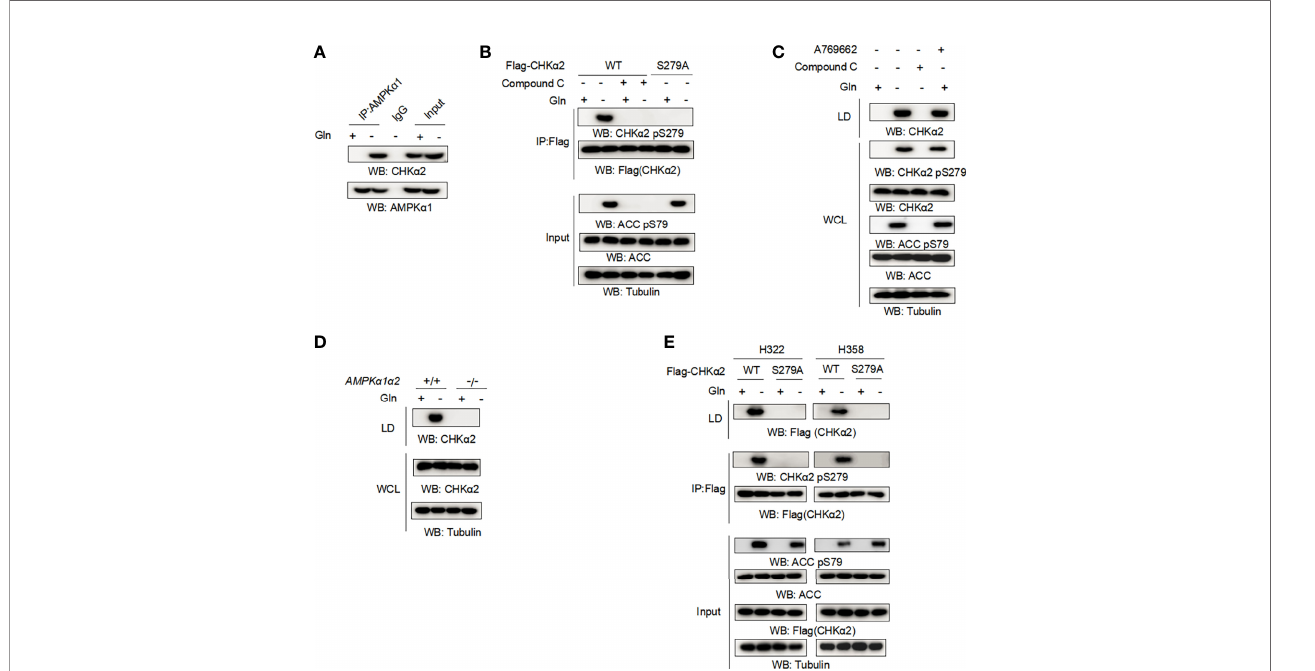
FIGURE 2 | Glutamine deprivation-induced and AMPK-mediated CHK a 2 S279 phosphorylation promotes the binding of CHK a 2 to lipid droplets. (A) H322 cells were stimulated with glutamine deprivation for 6 h. Immunoprecipitation with AMPK a 1 antibody and immunoblotting analyses with the indicated antibodies were performed. (B) H322 cells expressing WT-Flag-CHK a 2 or Flag-CHK a 2 S279A were treated with or without 5 m M Compound C for 6 h, followed by stimulation with glutamine deprivation for 6 h. Flag-CHK a 2 protein was immunoprecipitated, and immunoblotting analyses with the indicated antibodies were performed. (C) H322 cells were treated with 5 m M Compound C or 0.5 mM A769662 for 6 h and stimulated with glutamine deprivation for 6 h. The lipid droplets were puri fi ed and normalized to cell numbers. Immunoblotting analyses were performed with the indicated antibodies. (D) AMPK a 1 a 2-de fi cient MEFs were stimulated by glutamine deprivation for 6 h before lipid droplet puri fi cation. Immunoblotting analyses were performed with the indicated antibodies. (E) The indicated cells expressing WT- Flag-CHK a 2 or Flag-CHK a 2 pS279A were stimulated with glutamine deprivation for 6 h. Lipid droplets were puri fi ed and normalized to cell numbers. Immunoprecipitation of whole cell lysates was performed with an anti-Flag